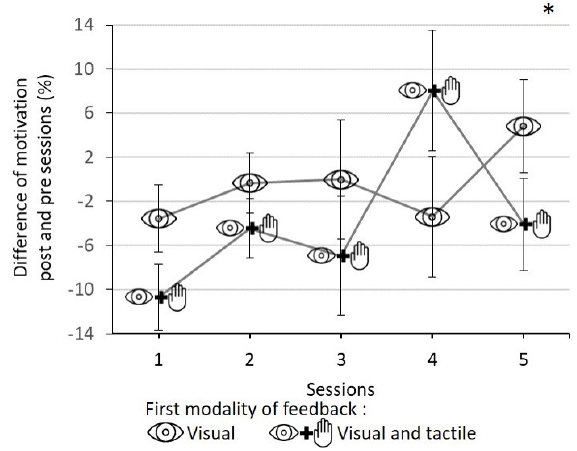
Figure 9. Evolution over the sessions of the motivation between the end and the beginning of session depending on the order of presentation of the modalities of feedback. The single * on the top corner represents how significant the interaction “Session*Order” represented in this Figure is, i.e., p ≤ 0.05.